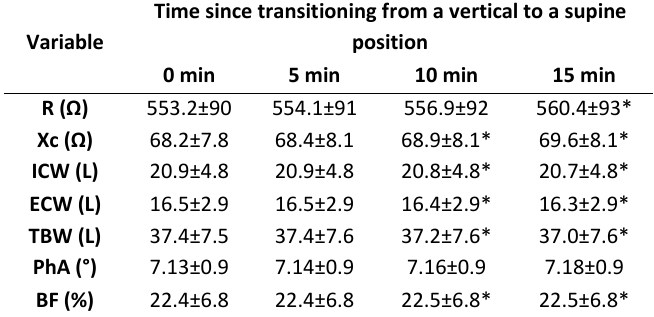
Table 2: Average bioelectrical variables as assessed by the RJL Quantum Legacy device (N=38)